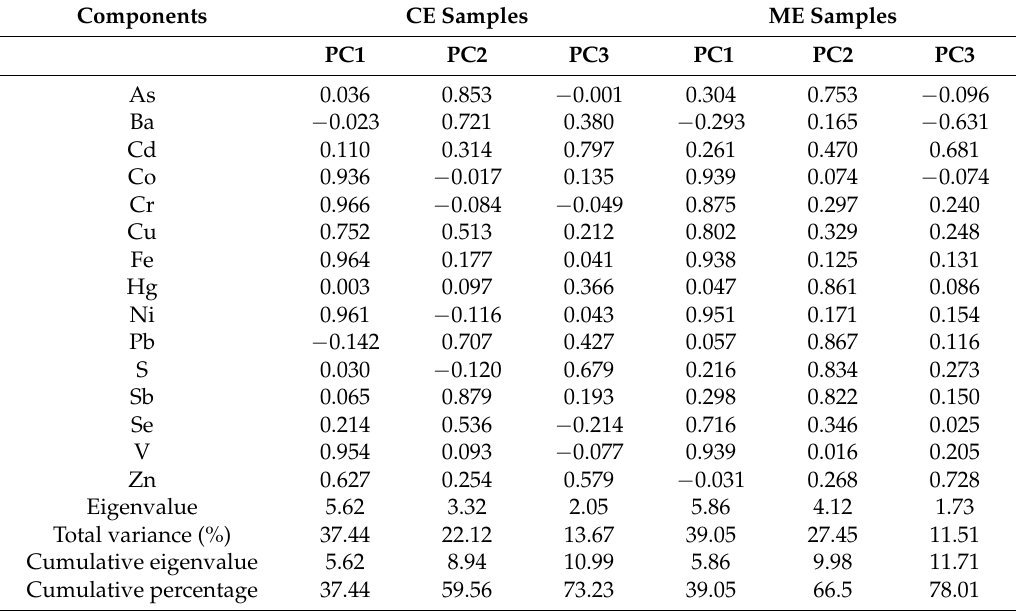
Table 3. Rotated factor loadings (varimax normalized) of selected metals in CE samples ( n = 168) and ME samples ( n = 83). Components CE